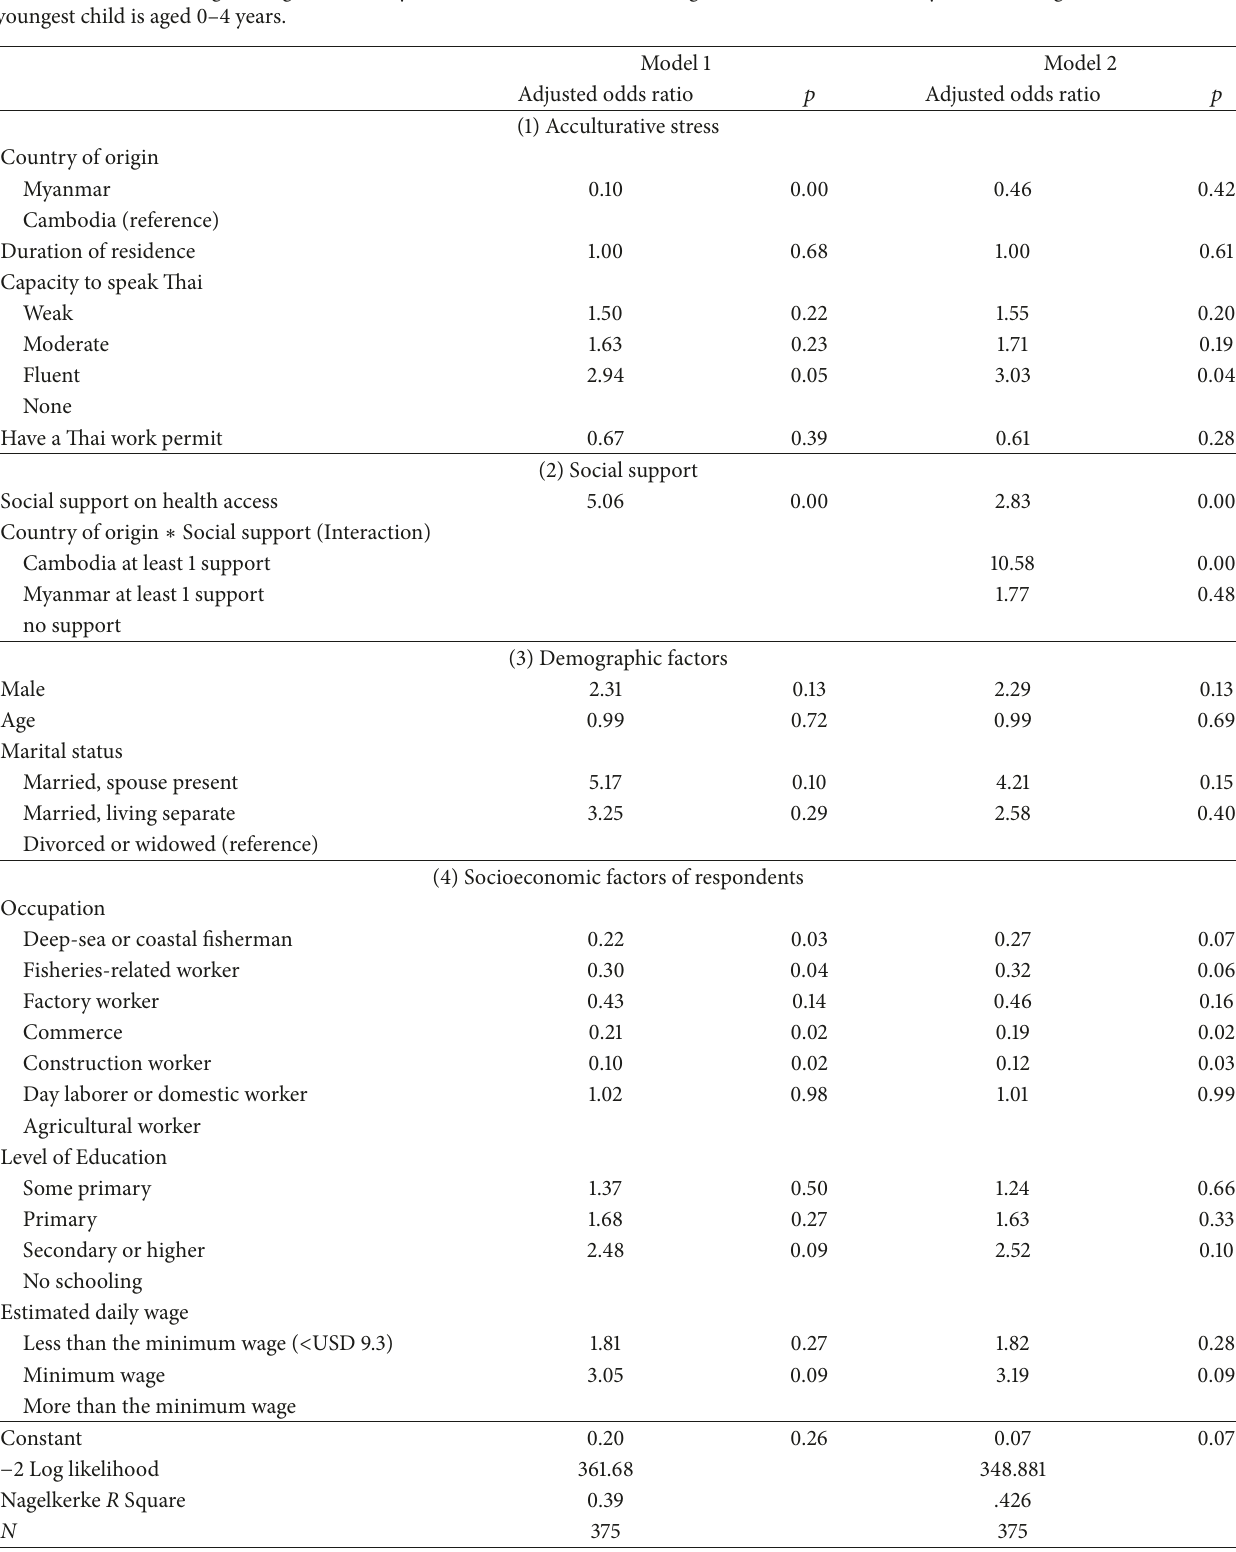
Table 3: Multivariate logistic regression analysis of factors related to receiving PPC after the last delivery for GMS migrant workers whose youngest child is aged 0–4